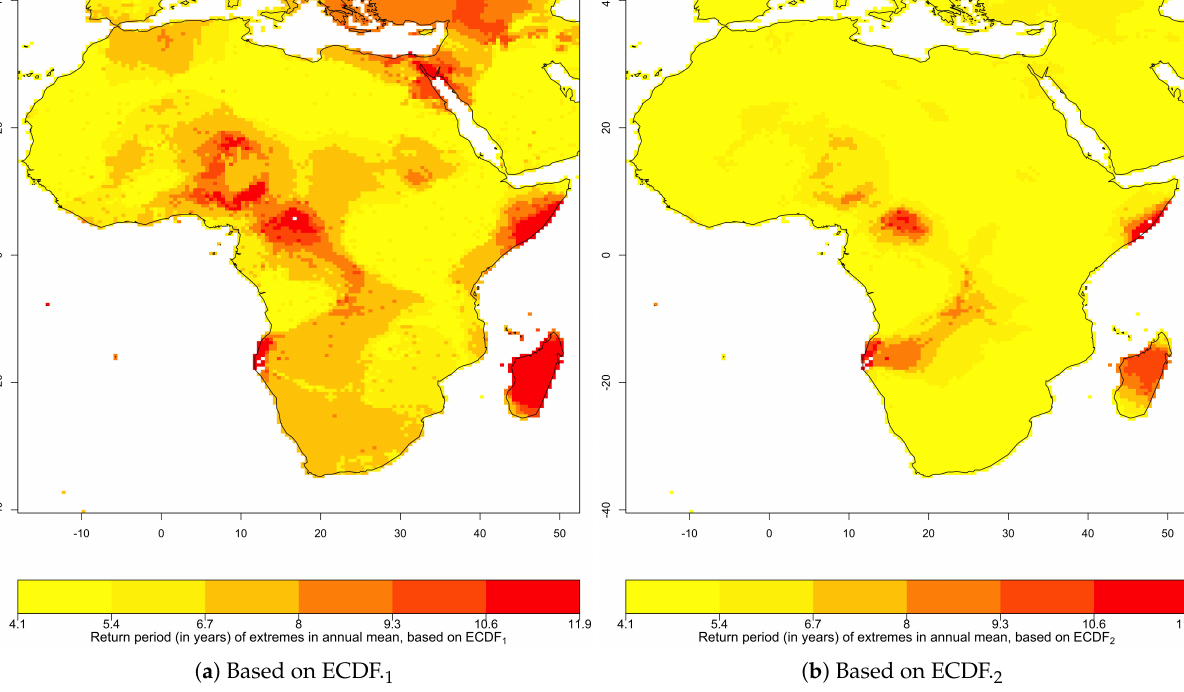
Figure 8. Return period of extremes in annual mean temperatures: ( a ) based on ECDF 1 and ( b ) based on ECDF 2 . Return period based on ECDF 2 is shorter than that based on ECDF 1 at most